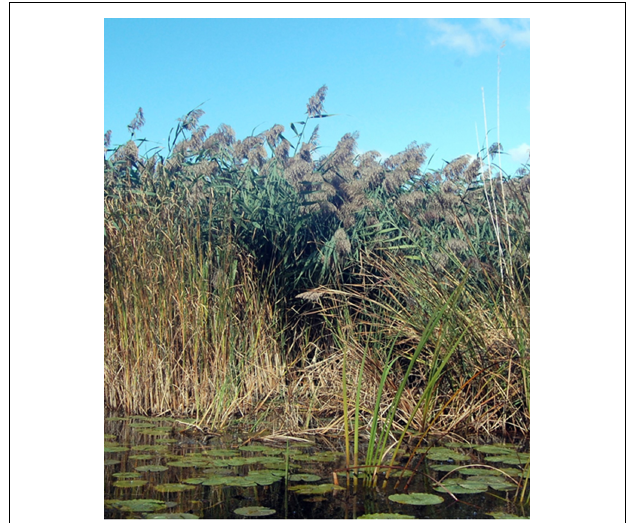
FIGURE 3 | Invasive Phragmites australis in a Great Lakes coastal